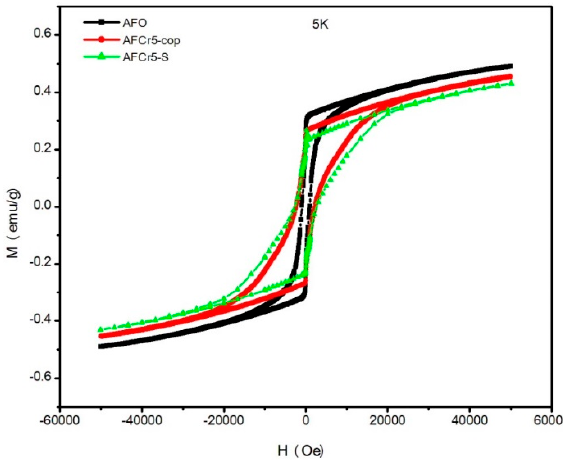
Figure 3. M–H hysteresis loops obtained at 5 K for AFCr5-s et AFCr5-cop. Figure 3. M-H hysteresis loops obtained at 5K for AFCr5-s et